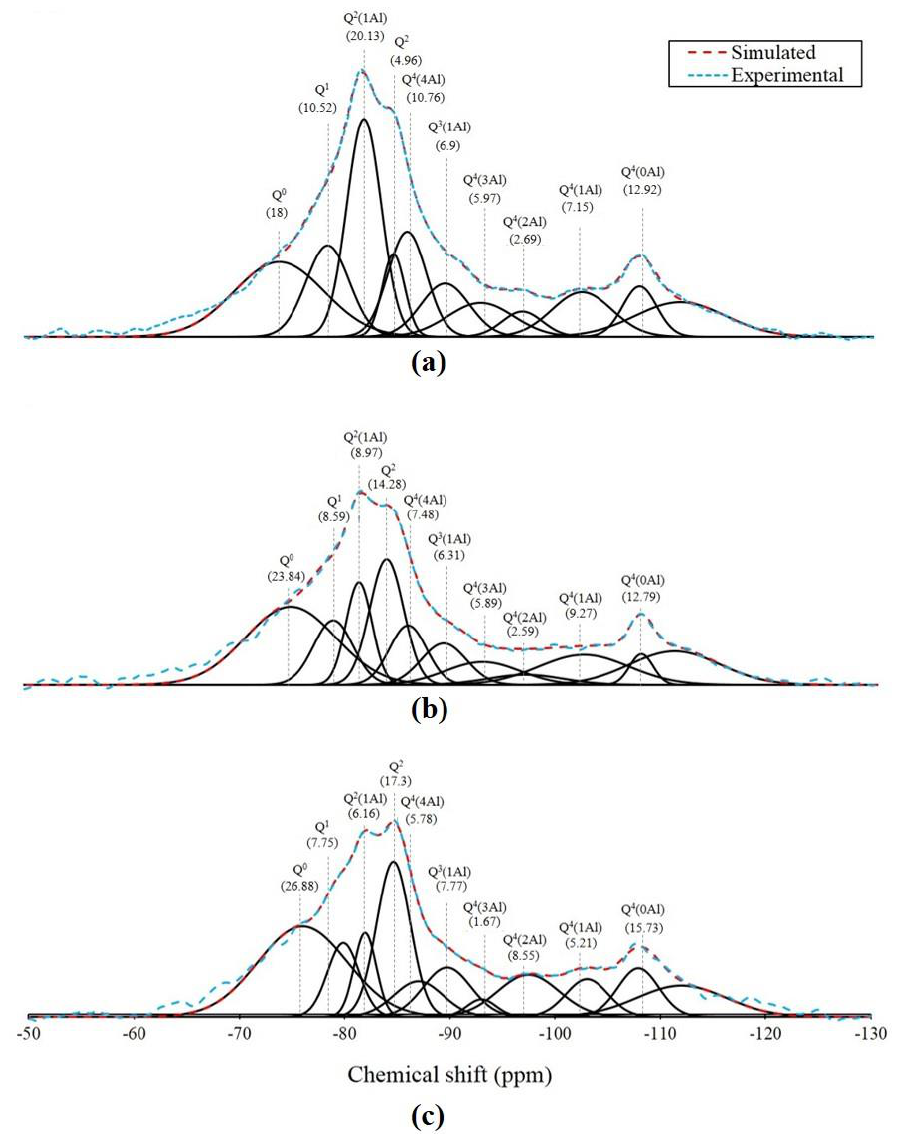
Figure 7. 29 Si NMR of the specimens on the 28th day, ( a ) 0% CaSO 4 , ( b ) 5% CaSO 4 , ( c ) 10% CaSO 4 .